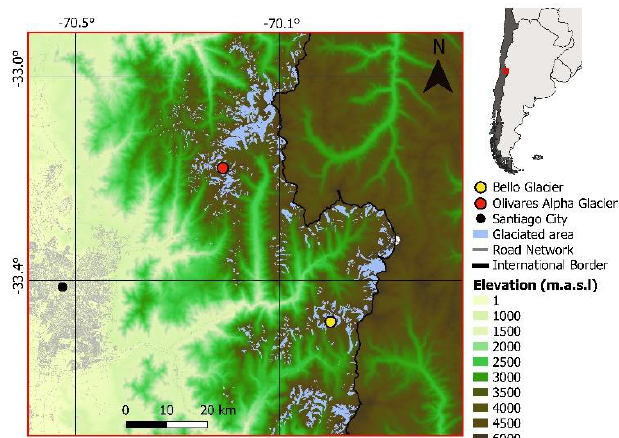
Figure 1. Study area and glaciers location